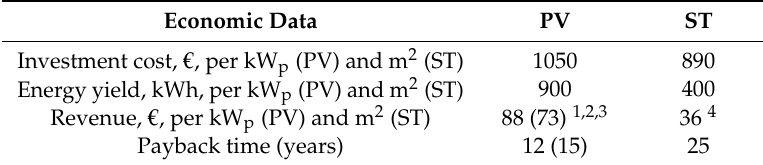
Table 6. Investment cost per unit, energy yield per unit, and revenue per kWh of energy.